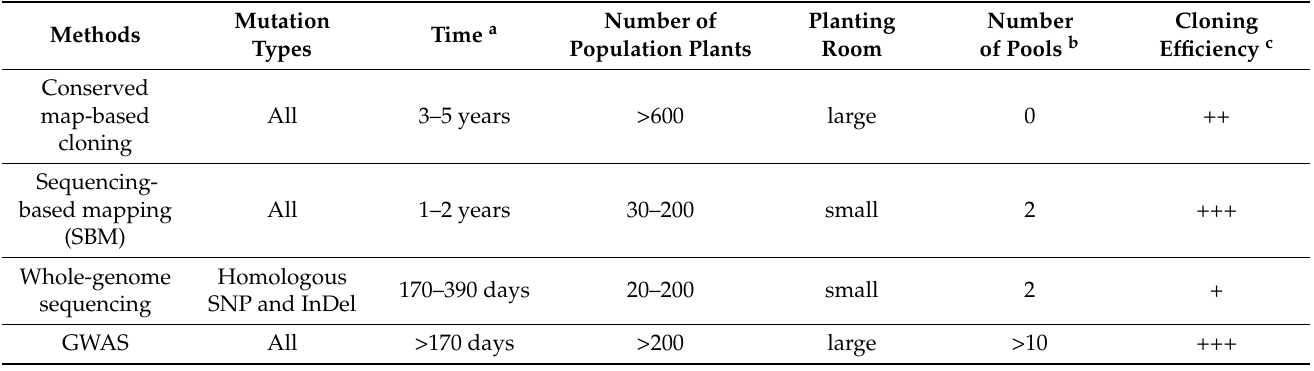
Table 2. Comparison of different cloning